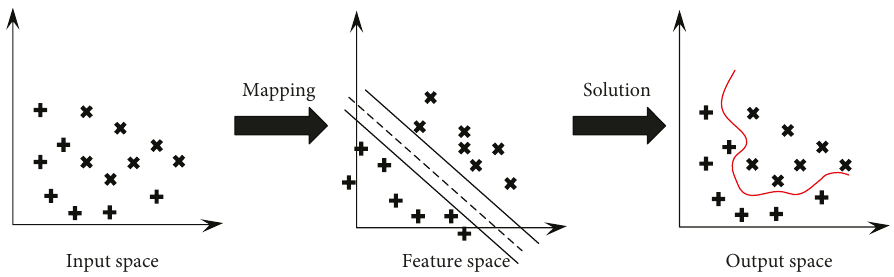
Figure 4: Nonlinear case of a schematic diagram of the SVM kernel